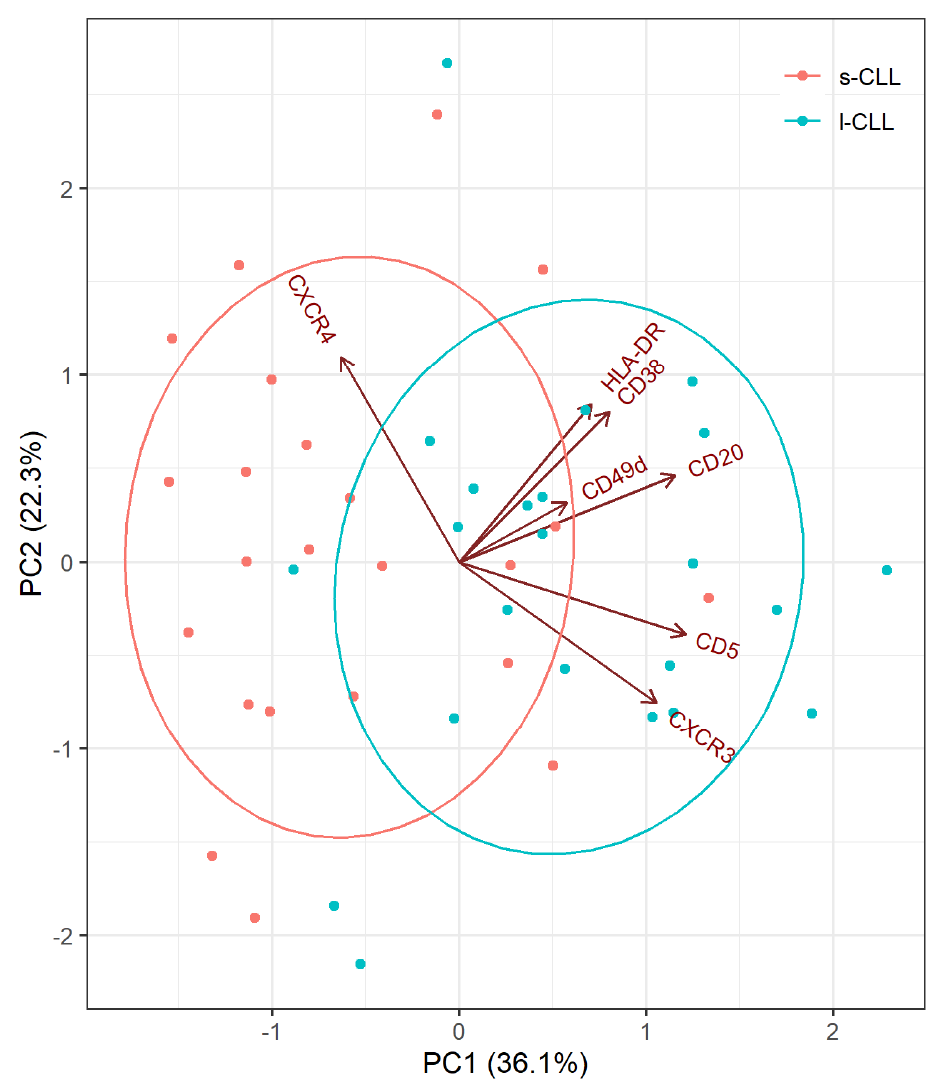
Figure 4. The PCA analysis of surface marker expression in s-CLL and l-CLL cells. Each dot represents a score for the s-CLL (blue) and l-CLL (pink) cell populations derived from the studied CLL patients ( n = 23). The model loadings are represented by vectors and indicate how each surface marker contributes to the cell variability in a specific direction. The percentage given is the explained variance per principal component of a patient.